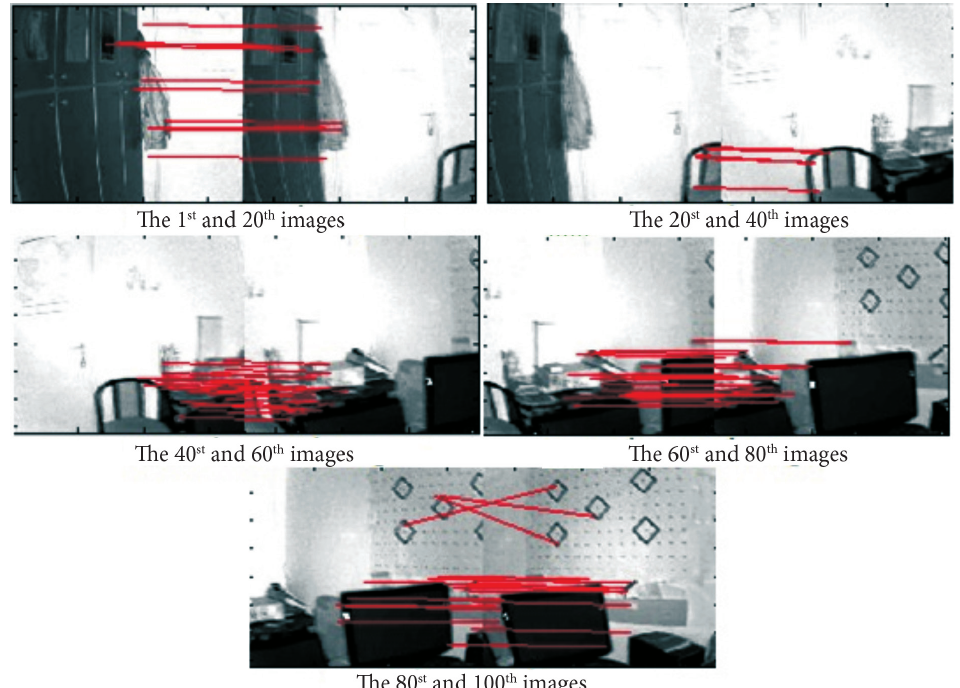
Fig. 5. The keypoints were extracted from the amplitude images by using SIFT. Three outlier keypoints between 80th and 100th images were